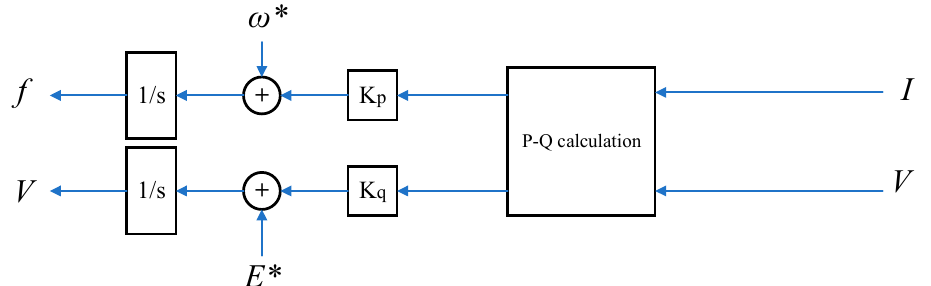
Figure 5. The general structure of droop control-based methods.